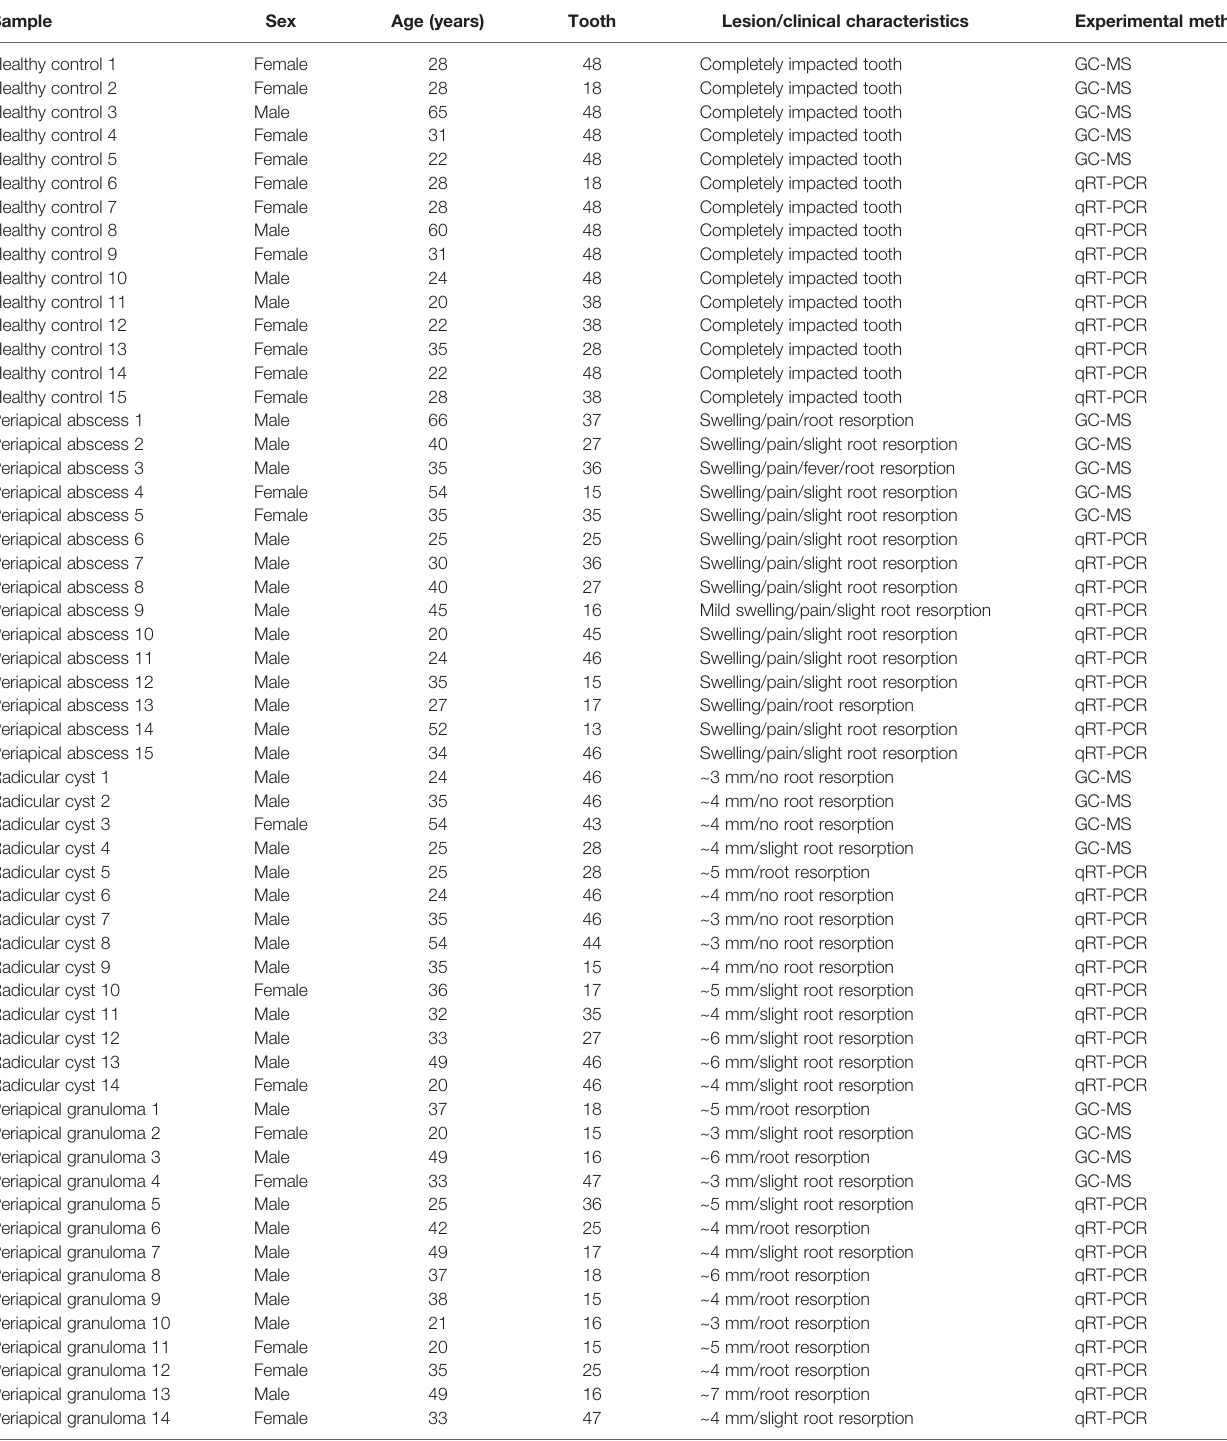
TABLE 1 | Clinical characteristics of the tissue samples involved in metabolomics and gene expression analyses.